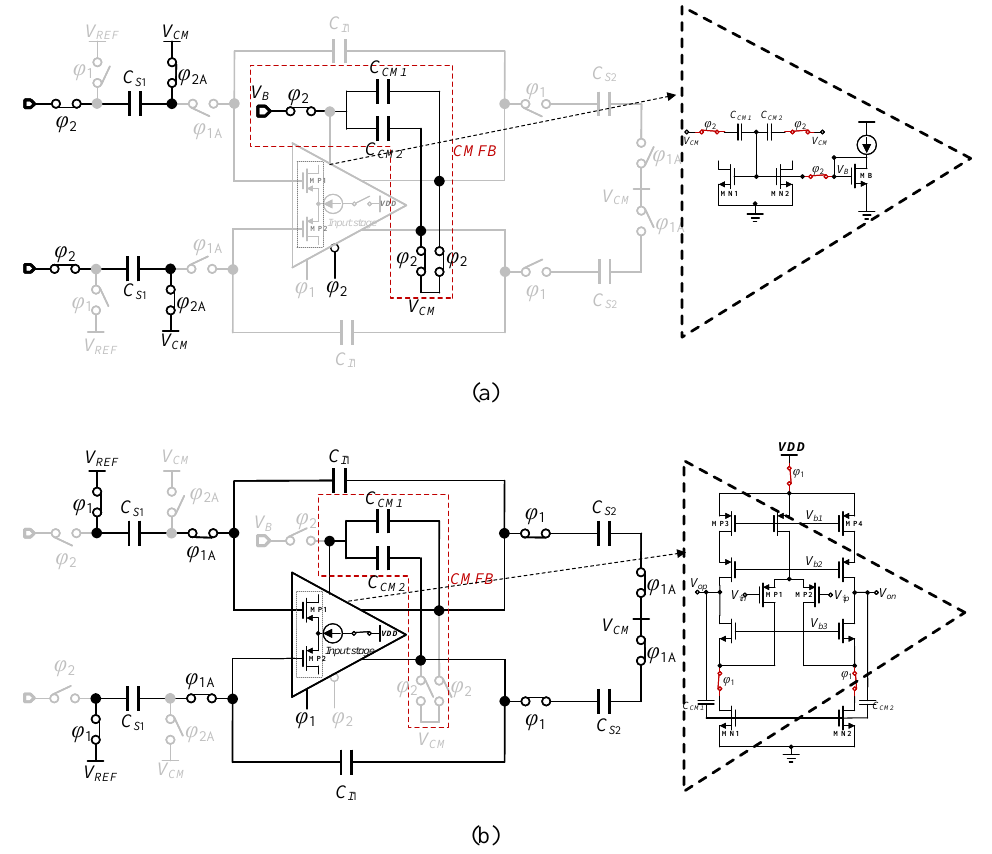
Figure 9. Working principle based on dynamic amplifier integrator: ( a ) sample/reset; ( b ) inte-